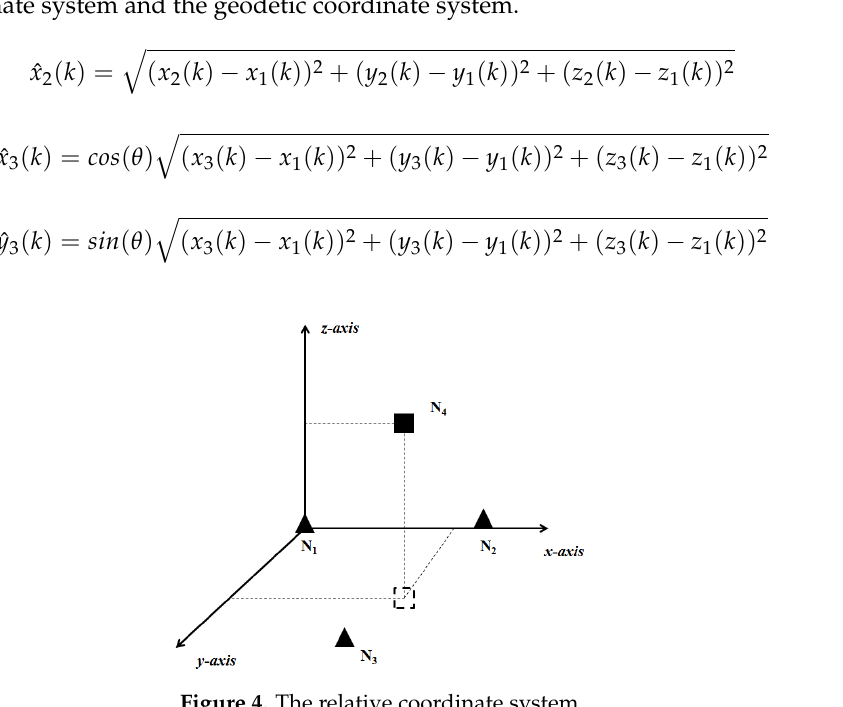
Figure 4. The relative coordinate